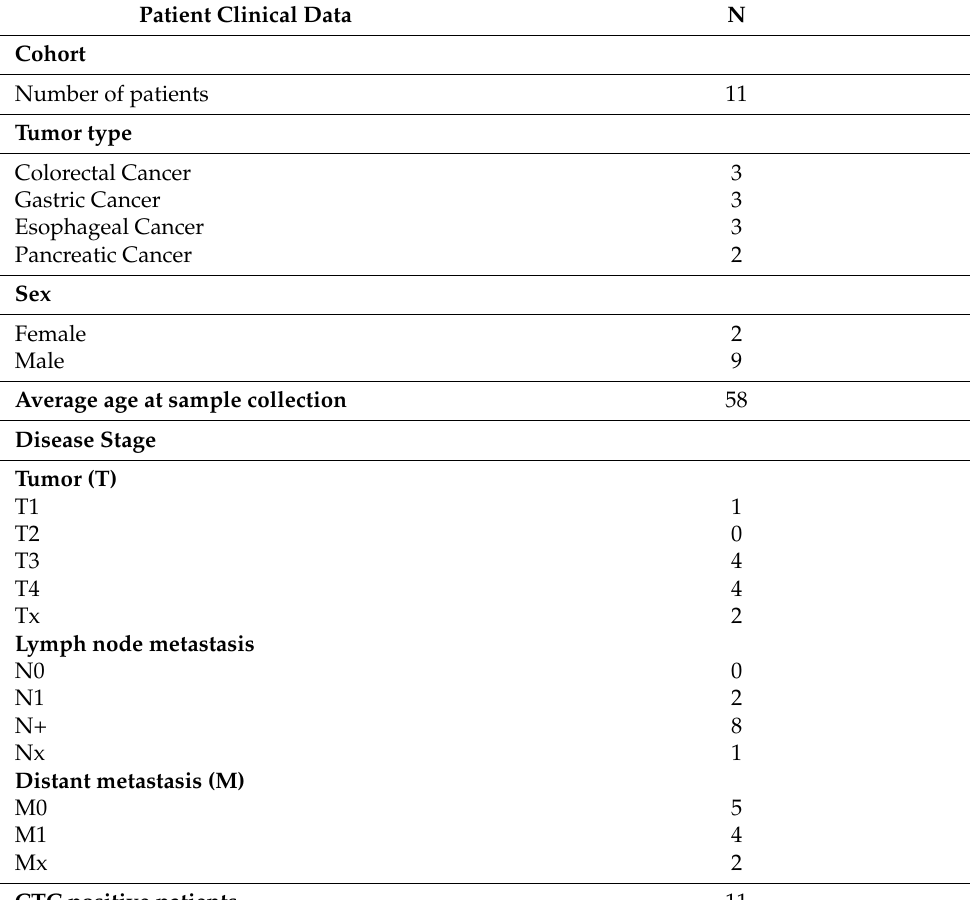
Table 2. Clinicopathological characteristics of patients enrolled in this